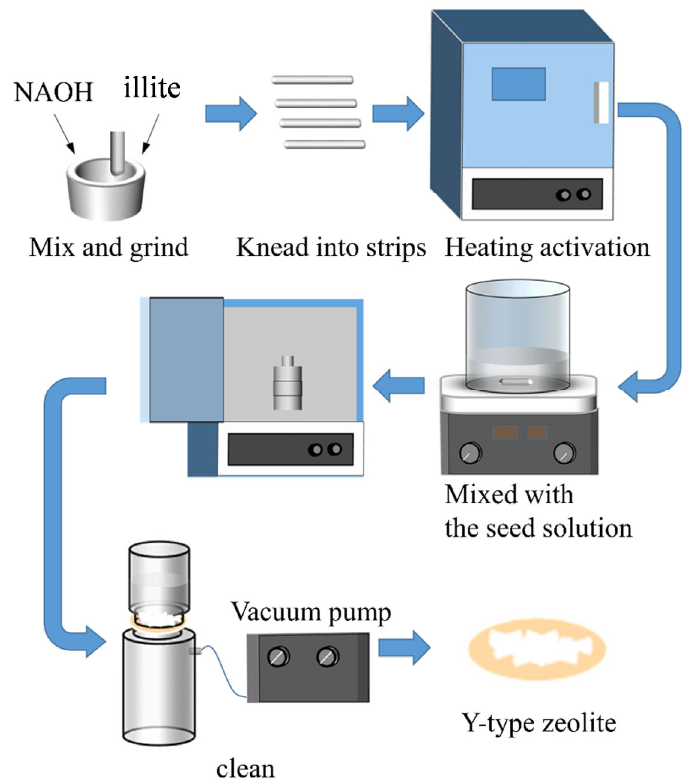
Figure 1. Diagram of synthesis of Y ‐ type zeolite.